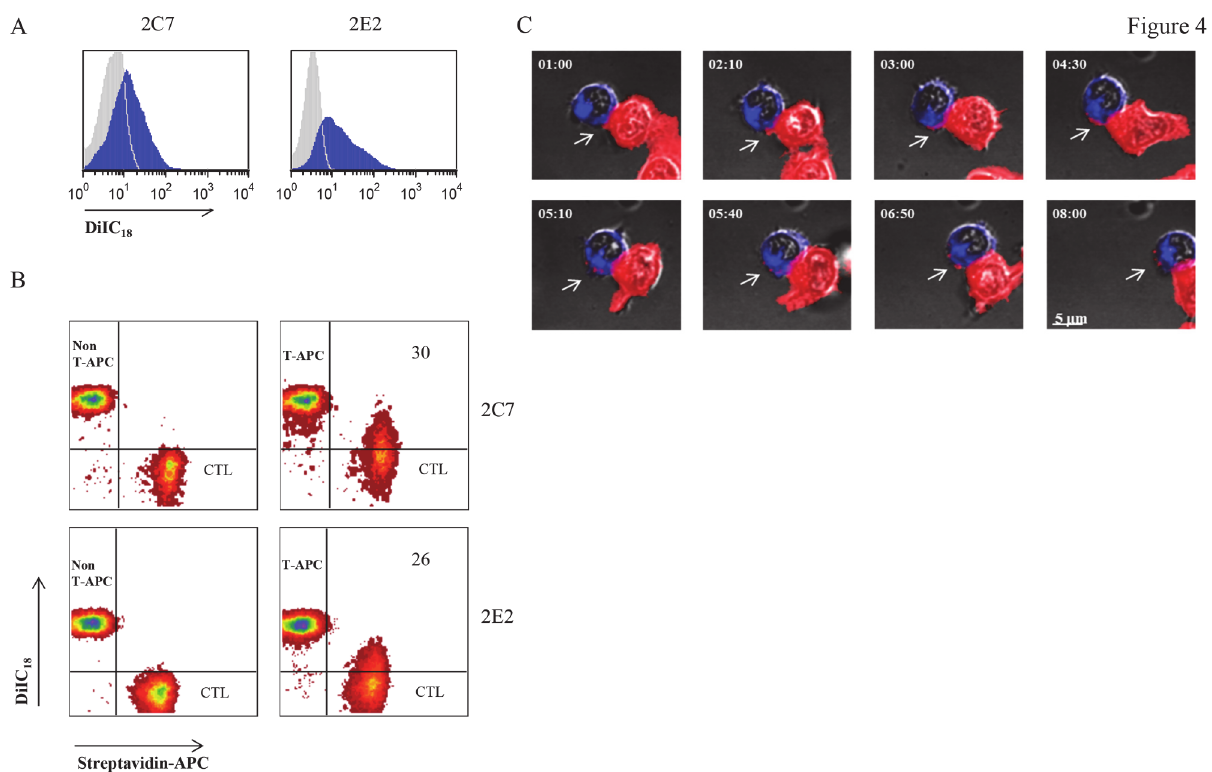
Fig 4. CD8 + T-APC induce secondary trogocytosis by tumor specific CTL. (A, B) CD8 + T-APCs and non-T-APCs were generated by co-incubation with cognate or irrelevant melanoma, respectively. They were then sorted, labeled with DiIC18 (see Methods) and co-cultured with surface biotinylated 2C7 or 2E2 clones (effector CTL). The culture was then stained with anti-CD8 antibodies and streptavidin- allophycocyanin, and subjected to flow cytometry. (A) Histograms indicate secondary trogocytosis by the presence of DiIC18 on 2C7 or 2E2 CTLs, gated on CD8 + streptavidin + populations, following co-culture with CD8 + T-APC ( blue ) or non-T-APC ( grey ). (B) Secondary trogocytosis was measured by presence of DiIC18 on the CD8 + streptavidin + population (effector CTL) and streptavidin-allophycocyanin on the CD8 + DiIC18 + population ( left column , non-T-APC, right column , T-APC). Numbers in upper right quadrants indicate the percentage of DiIC18- stained effector CTL (performing secondary trogocytosis). (C) PKH67-labeled CD8 + T-APCs ( red ) were co-cultured with PKH26-labeled effector CTLs ( blue ). The lymphocytes were co-incubated in a chambered cover-glass and subjected to confocal microscopy. A snapshot series of 8 min is presented. Arrows , transfer of membrane fragments (secondary trogocytosis) from CD8 + T-APC to CTL. Scale bars, 15 μ m. Data are representative of at least five independent experiments (A, B) or of three experiments (C).